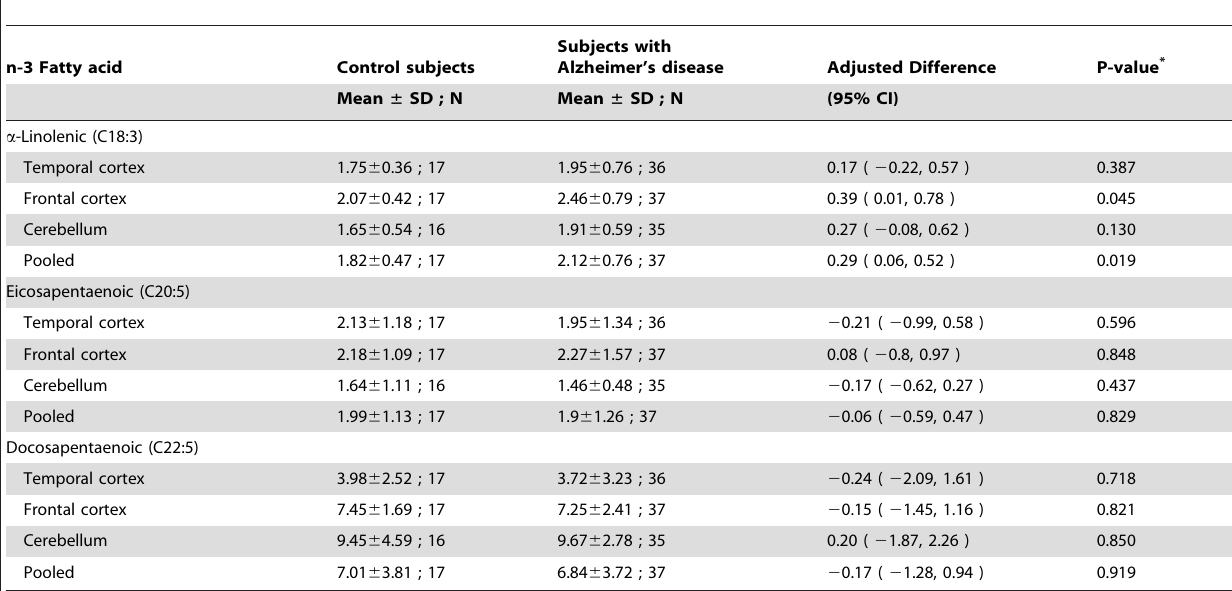
Abbreviations: CI, confidence interval. *P-values for differences between means were computed by linear regression analysis for each fatty acid in selected brain regions and Generalized Estimating Equations for the pooled analysis in the entire brain after adjustment for age, gender, and post mortem interval. doi:10.1371/journal.pone.0012538.t002 PLoS ONE |